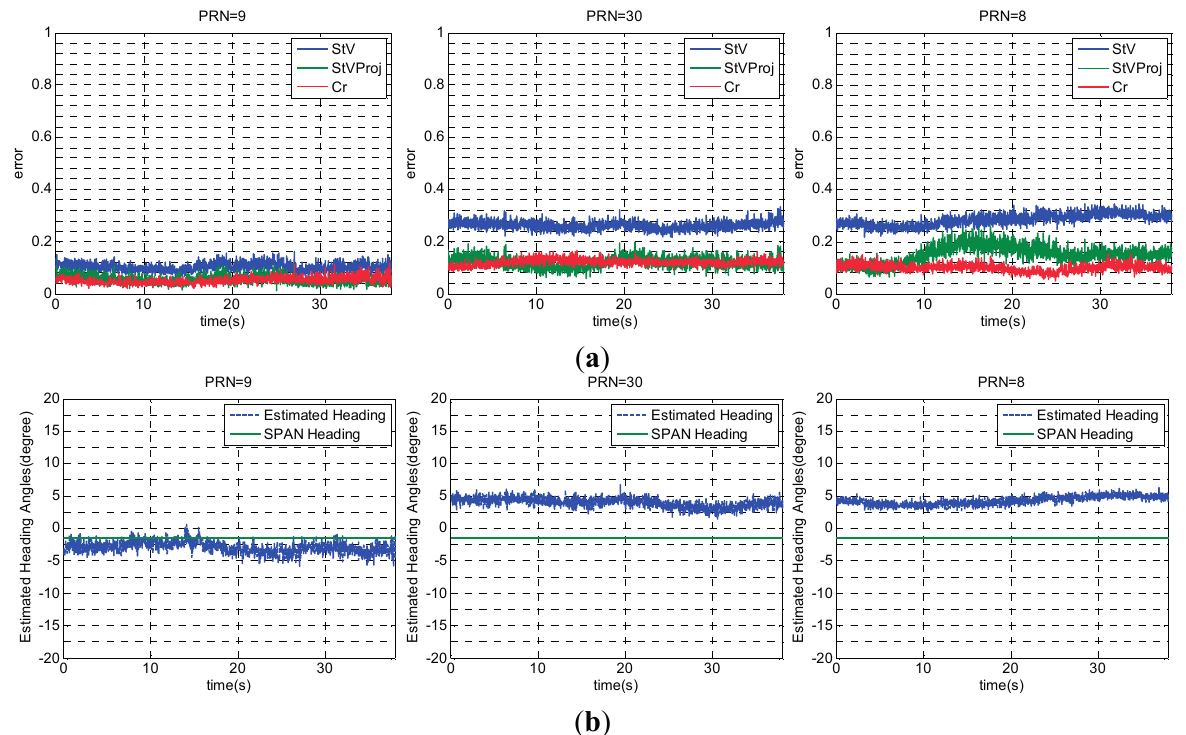
Figure 8. ( a ) Comparison of estimated steering vectors ( b ) and estimated heading angles for PRN 9, 30 and 8.